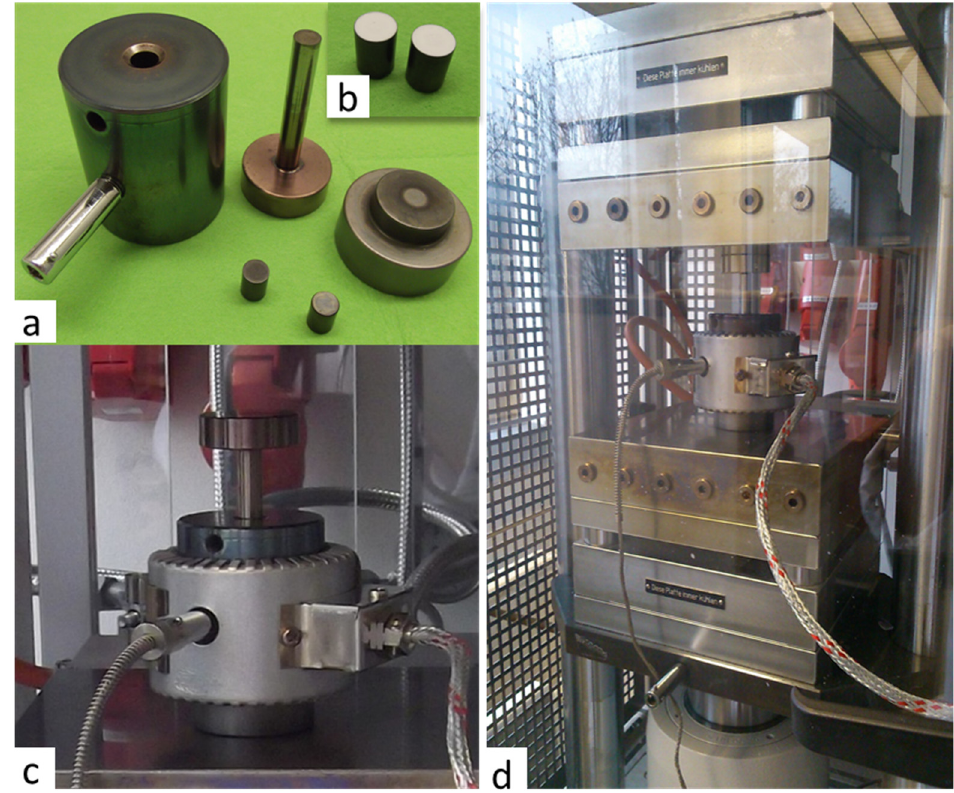
Figure 1. Experimental setup used for cold sintering: ( a ) pellet die 10 mm diameter; ( b ) dies with h-BN anti-adhesion coatings; ( c ) heating band around the pellet die; ( d ) electro-hydraulic 2-column laboratory press with mounted pellet die and heating system.